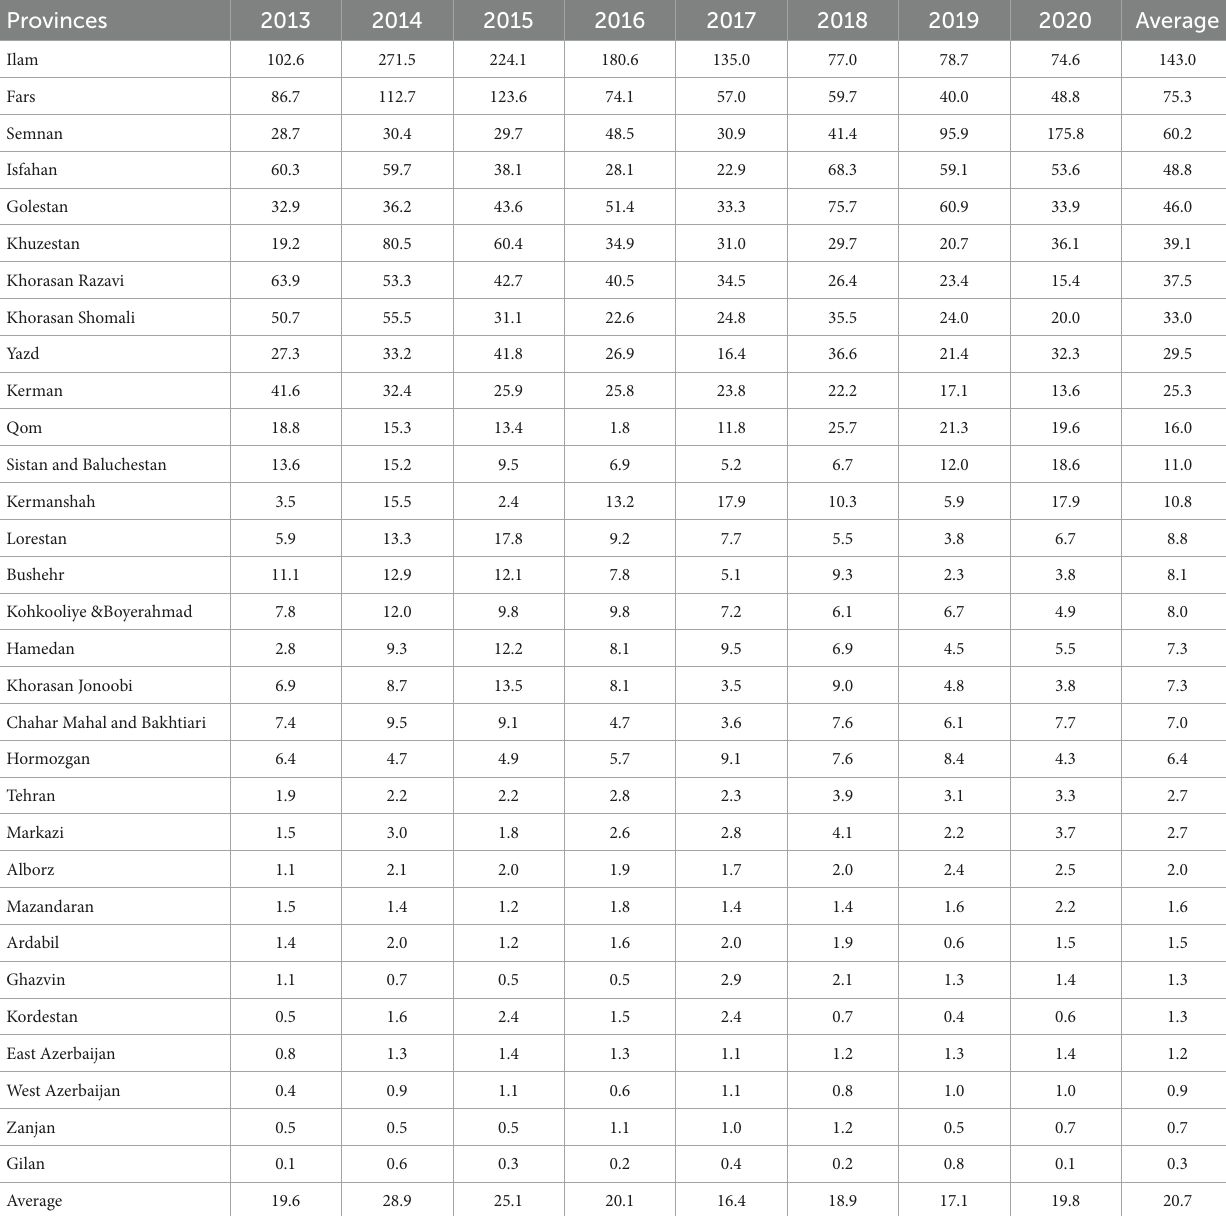
TABLE 1 Annual incidence (per 100,000 population) trends of cutaneous leishmaniasis in various provinces of Iran, 2013–2020.